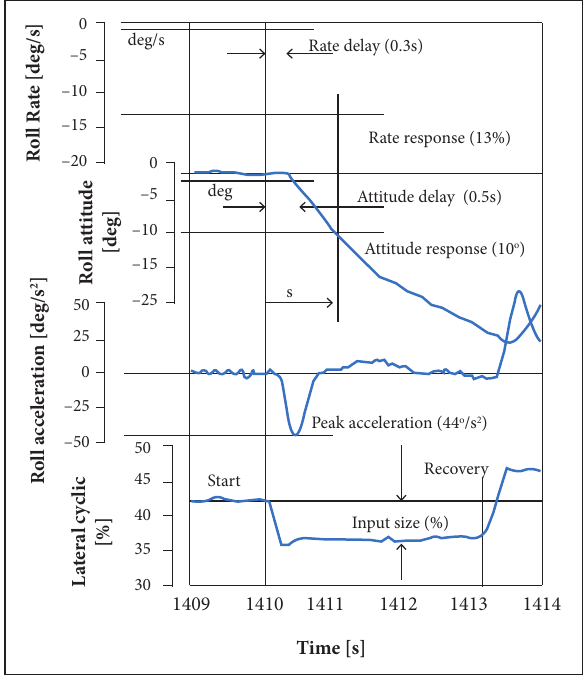
Figure 2. Characteristic parameters of a rotary-wing aircraft response — open-loop test (Cooke and Fitzpatrick